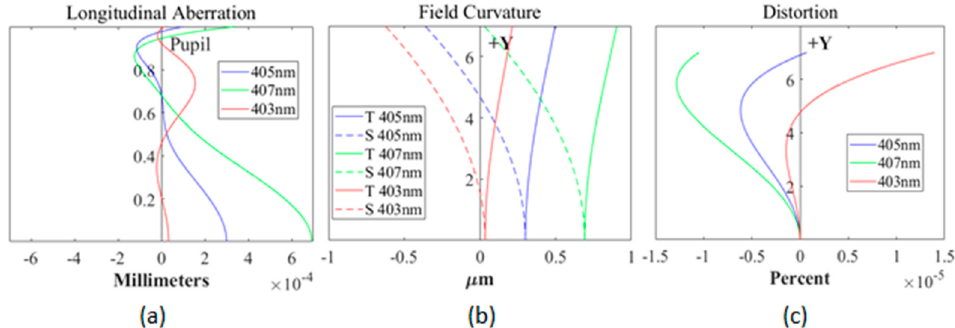
Figure 6. Longitudinal aberration of the hybrid projection lens system ( a ), field curvature ( b ), and distortion ( c ) of the hybrid projection lens system.